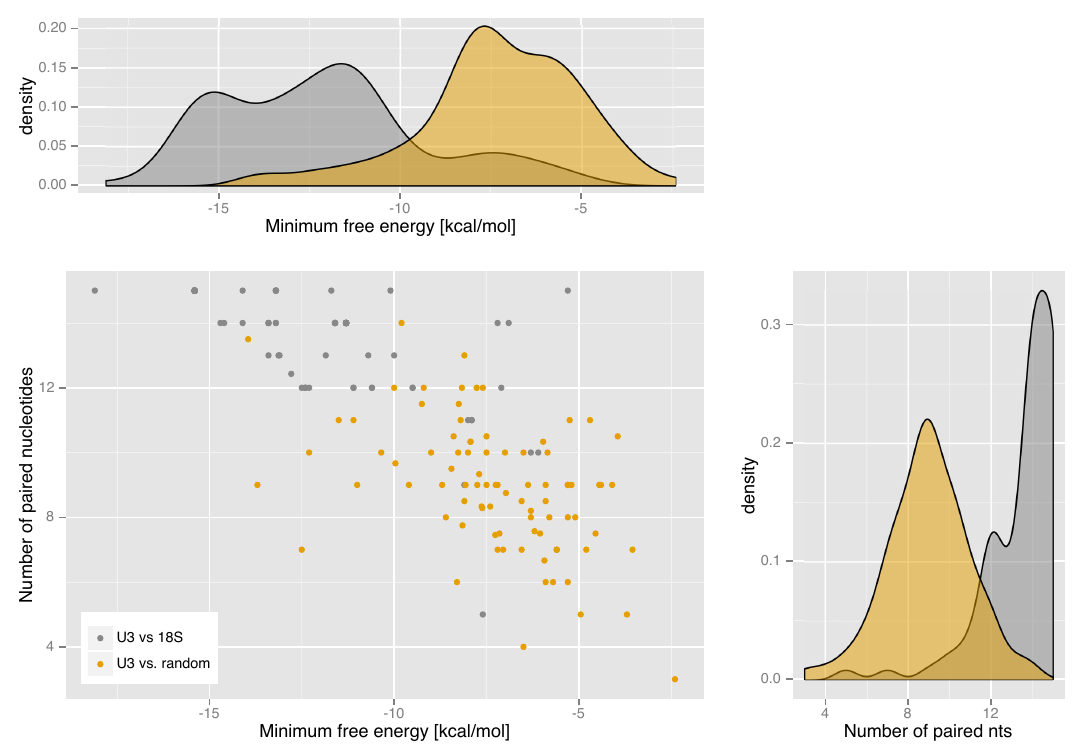
Figure 2. U3:pre-rRNA interactions are significantly more stable than random RNA:RNA interactions with the same sequence composition. Energies and minimum free energy interaction structures are computed with RNAduplex . The scatter plot shows the expected correlation between interaction energies and number of base